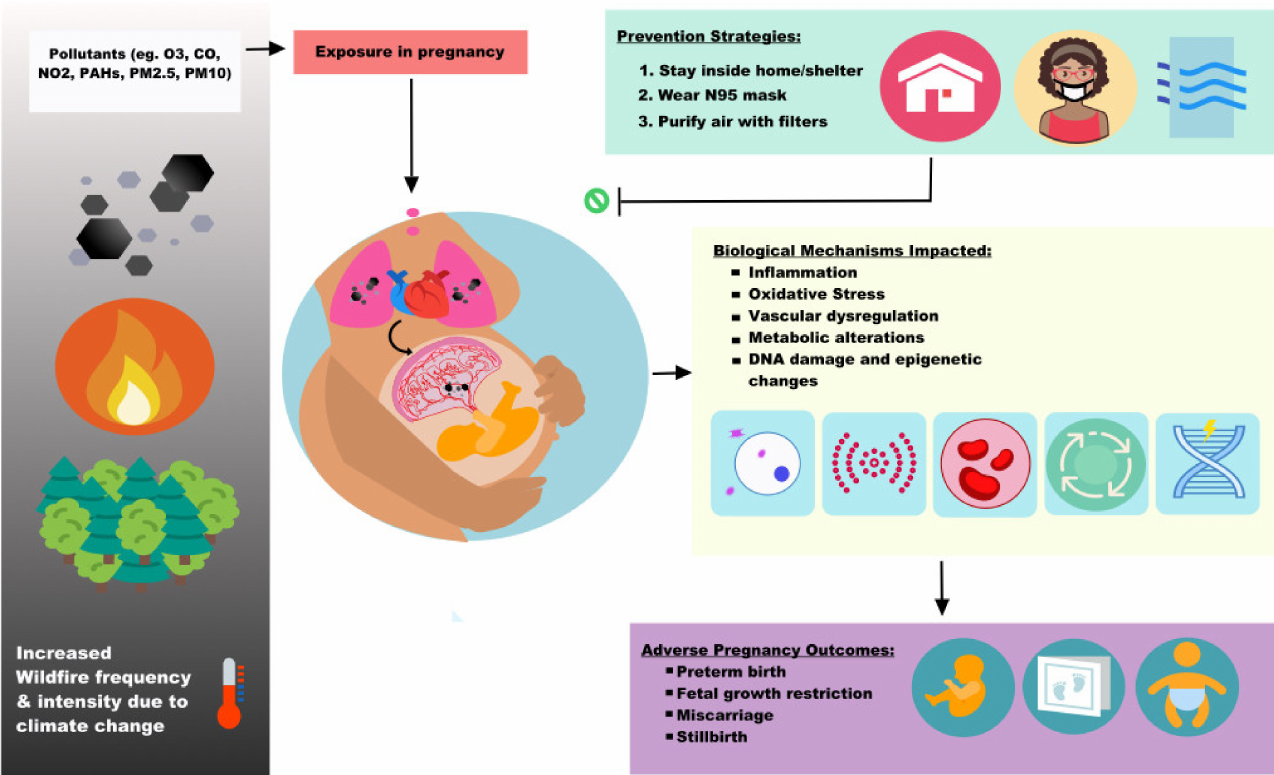
Figure 2. Wildfire smoke exposures and pregnancy implications. As climate change elevates global temperatures, wildfires are becoming more frequent, intense, and destructive. Wildfire smoke (WS) is a complex mixture of particulate matter (PM), gases such as ozone (O 3 ), carbon monoxide (CO), nitrogen dioxide (NO 2 ), polycyclic aromatic hydrocarbons (PAHs), heavy metals, elemental and organic carbon, in addition to volatile and semi-volatile organic compounds. Pregnant persons are especially susceptible to the adverse health effects of WS pollution due to the increased respiration and cardiovascular output in pregnancy. WS exposures in pregnancy can impact multiple biological mechanisms and contribute to inflammation, oxidative stress, vascular and endothelial dysfunction, metabolic alterations, and DNA damage as well as epigenetic changes. These alterations can lead to adverse pregnancy outcomes such as preterm birth (PTB), fetal growth restriction, and pregnancy loss. This highlights the importance of prevention strategies such as staying indoors, wearing a high-quality mask, and air